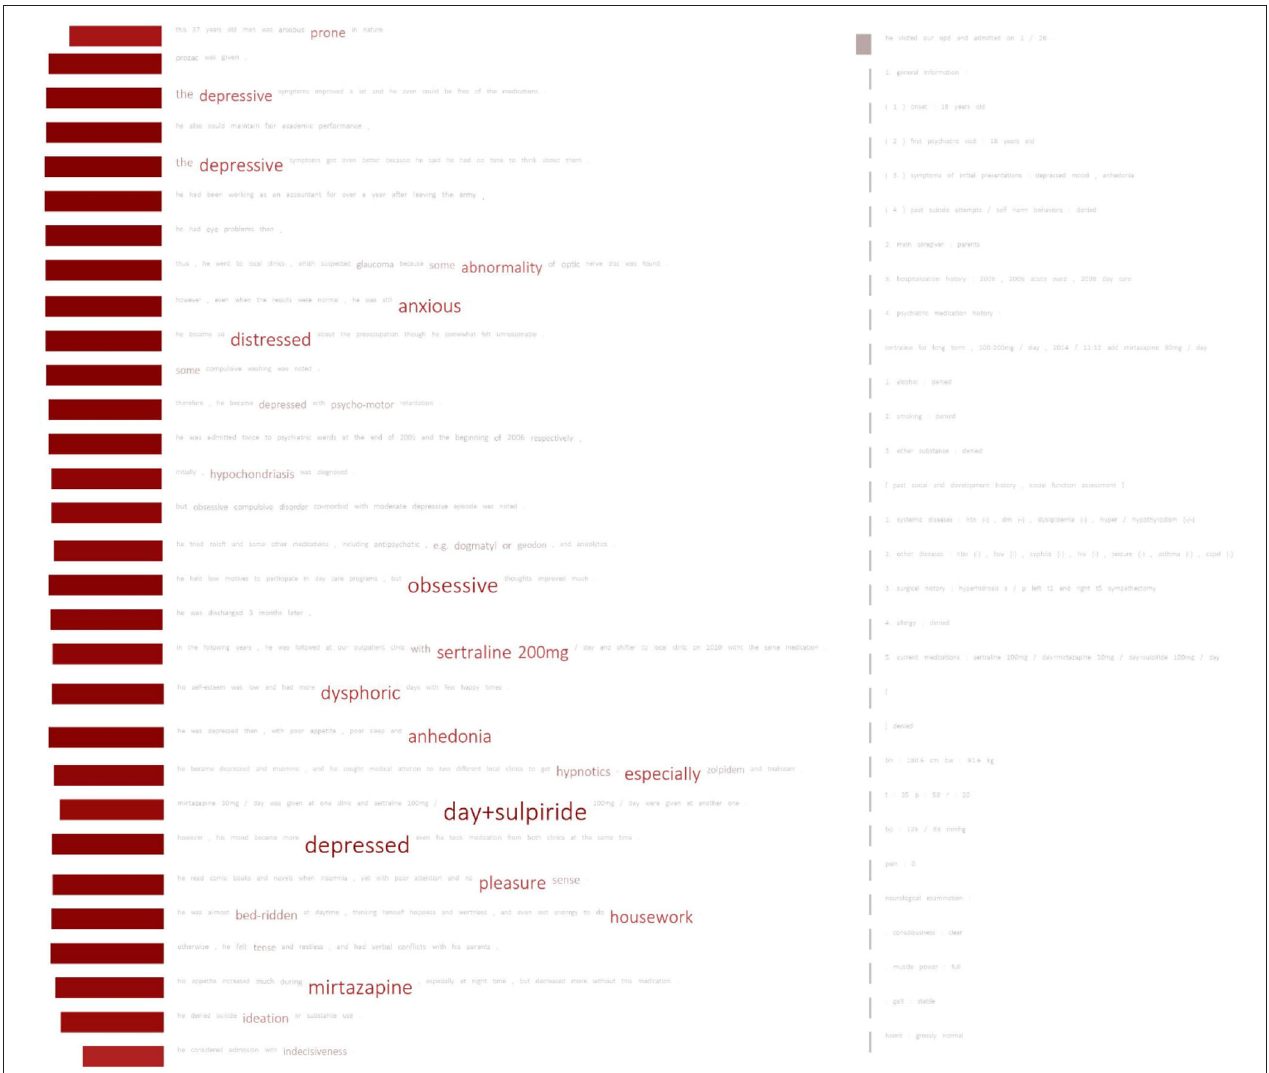
FIGURE 6 | Important terms used by the HAN model for classifying a patient with major depressive disorder. The font size of a word indicates the attention score. Words with higher scores appear in larger font sizes. The rectangle shown in front of each sentence indicates the importance (attention score) of the sentence. Larger rectangles signify more important